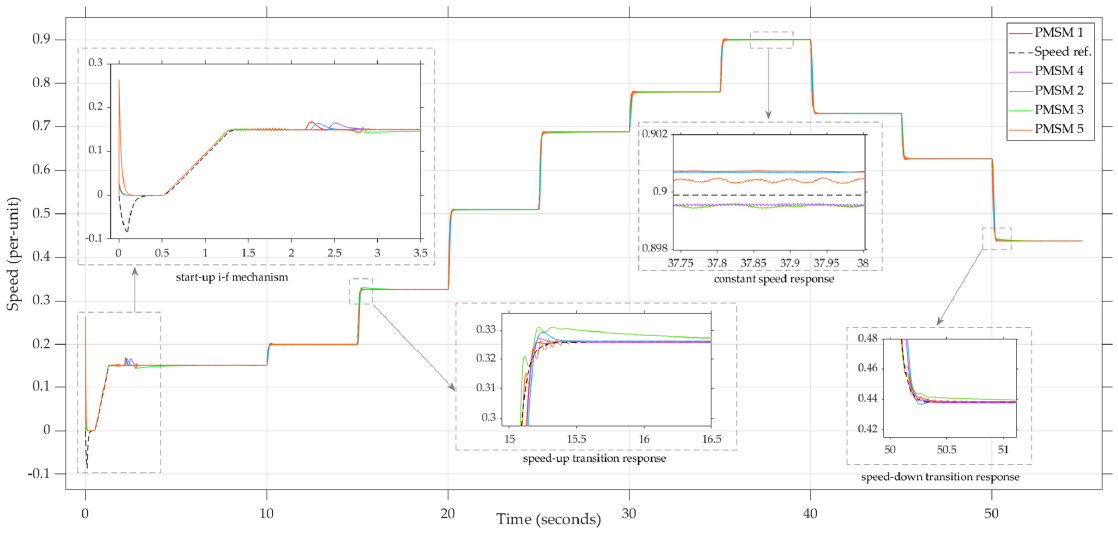
Figure 14. Rotor speed simulation results for all